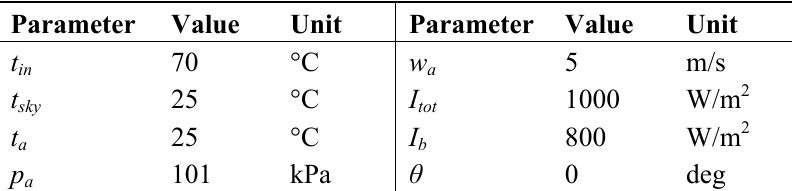
Table 3. CPVT boundary